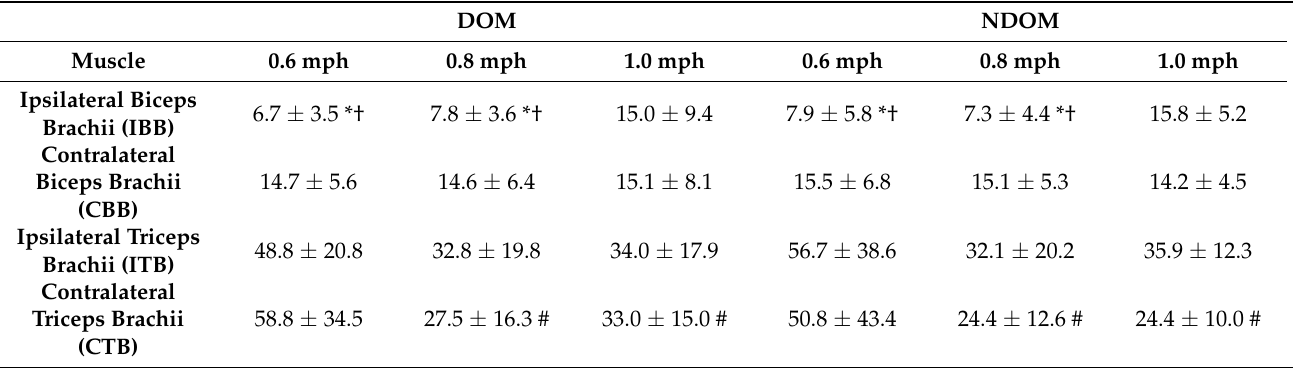
Table 2. Upper body electromyography (mV) signals standardized to BW ( n = 12). Data are presented as mean ± SD. * indicates significantly different from 1.0 mph within conditions ( p < 0.05). # indicates significantly different from 0.6 mph within conditions ( p < 0.05). † indicates significantly different from CBB at same speed ( p <